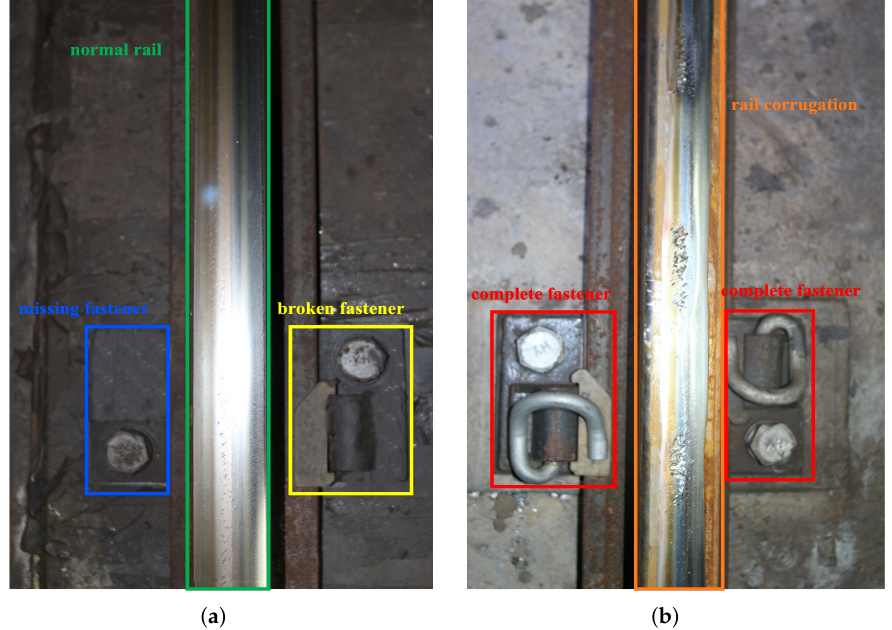
Figure 8. Defects of railway track line of Beijing Metro Line 6. ( a ) missing fastener and broken fastener; ( b ) rail